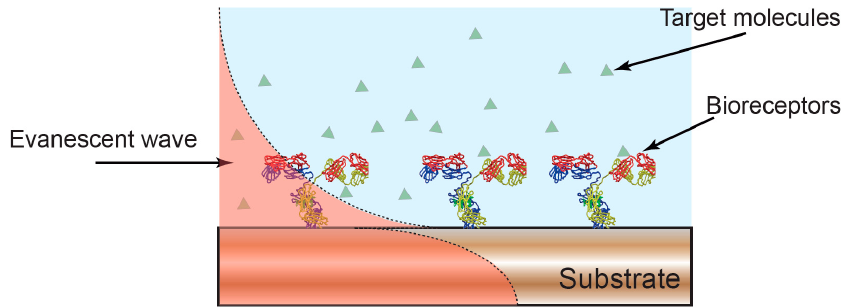
Figure 1. Optical biosensors based on evanescent wave detection. The properties of the optical mode confined in a photonic substrate are sensitive to the overlap between the evanescent field and the surrounding environment. A change in the local refractive index, for example, due to formation of an antibody-antigen complex, leads to a change in the properties of the confined optical mode and to a quantifiable readout of molecular binding.